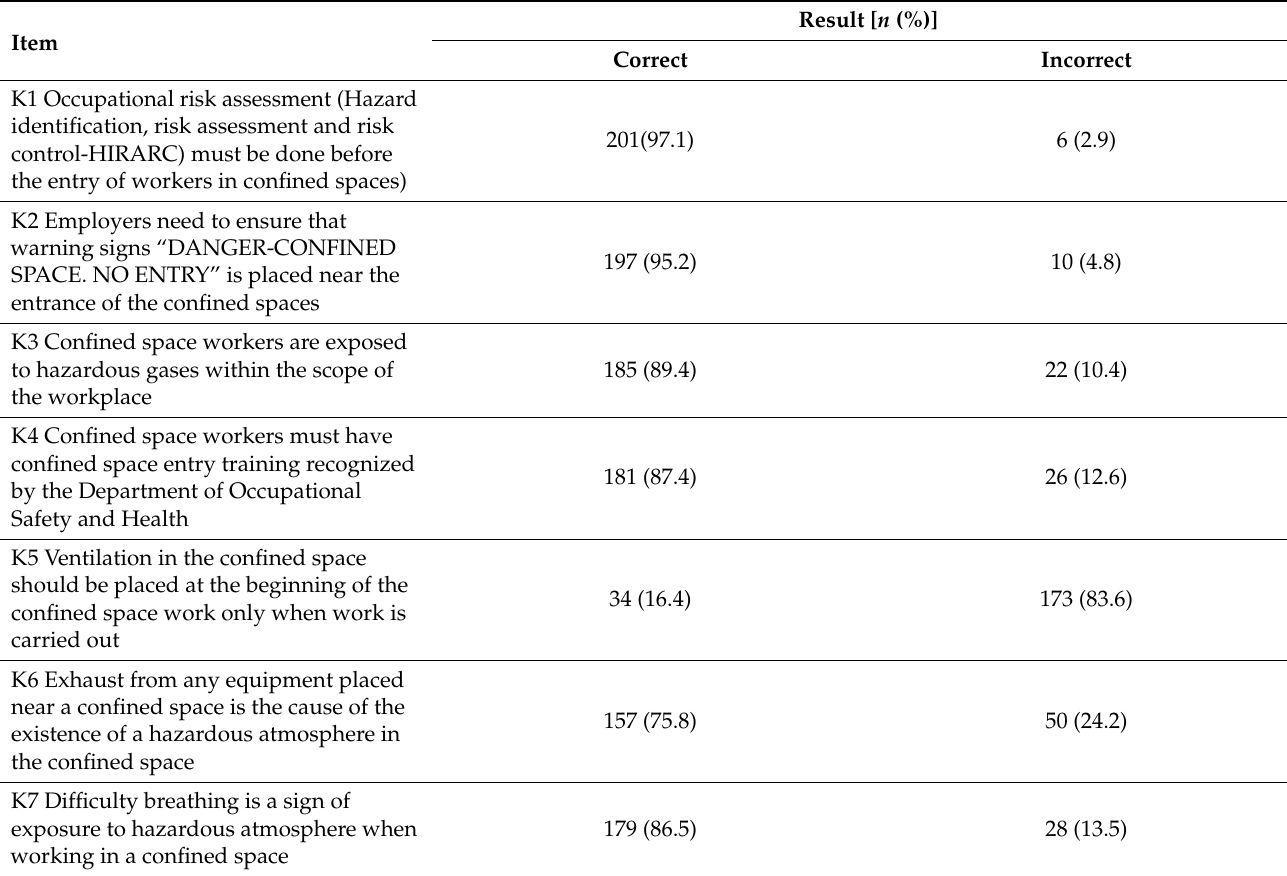
Table 1. Descriptive statistics of knowledge on safe working in a confined space among water services workers ( n =